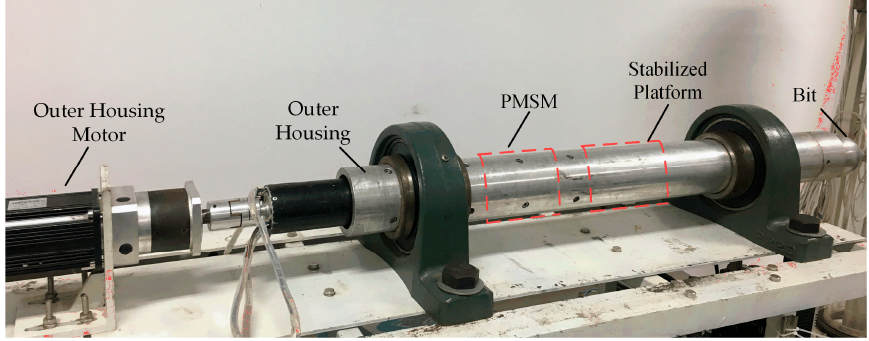
Figure 18. DPRSS Prototype.